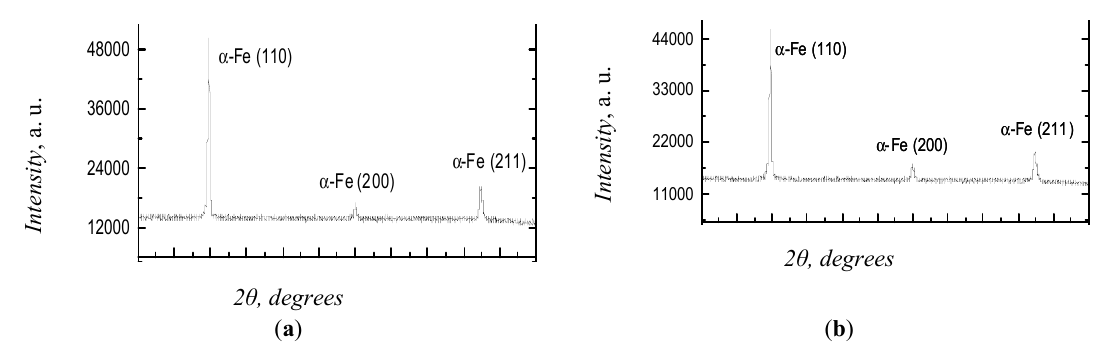
Figure 3. XRD patterns of the steel specimens: ( a )—before exposure to; ( b )—after exposure.